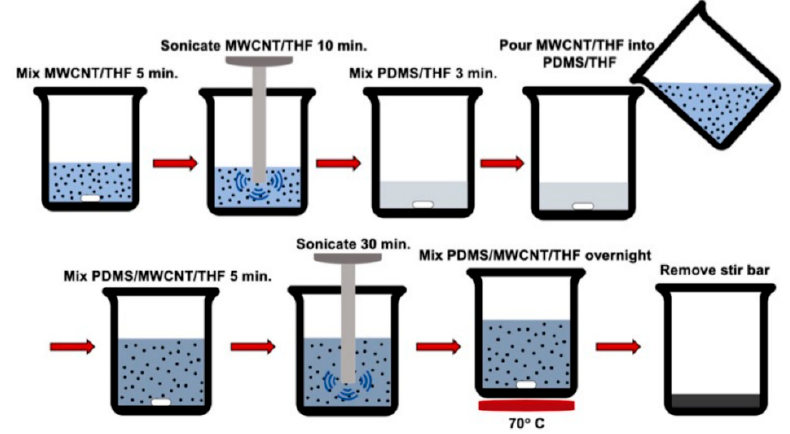
Figure 1. Schematic of the nanoparticle dispersion process used to fabricate the nanocomposite resin.